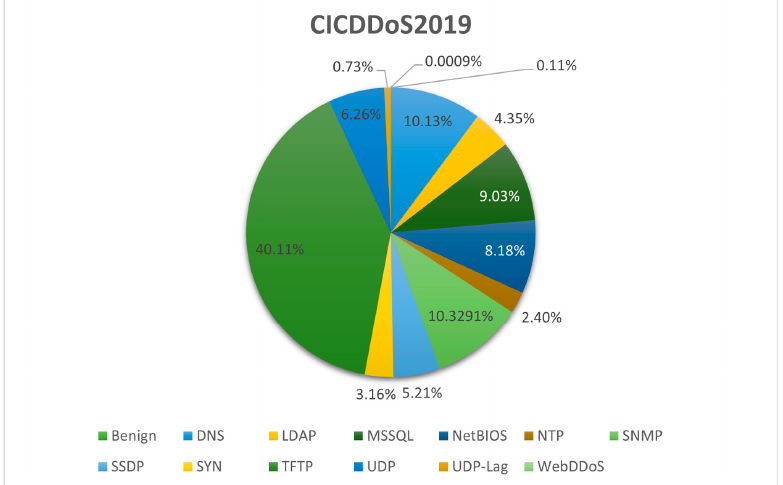
Figure 1. The percentage of traffic types of the CICDDoS2019